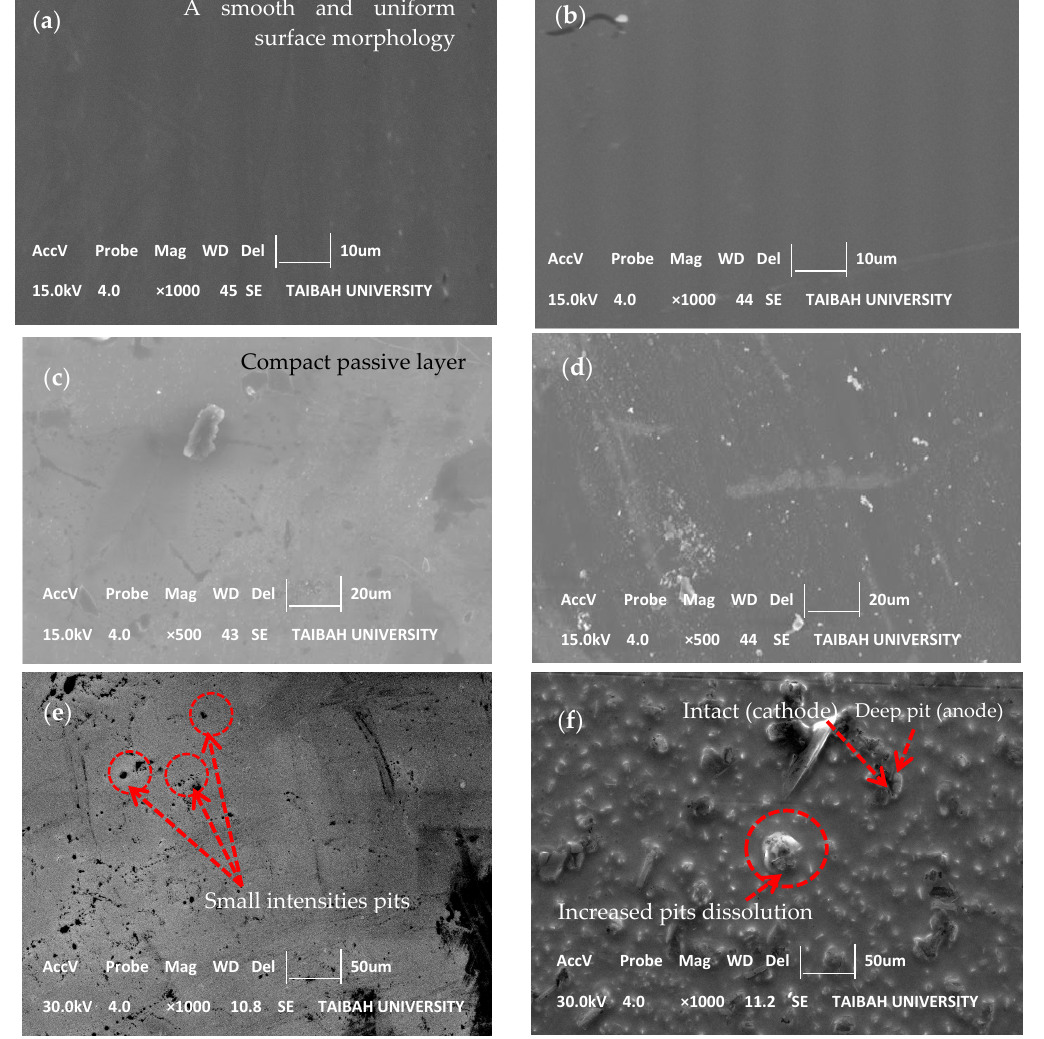
Figure 6. SEM morphology for Ni-base glassy alloys at as-received and different concentration of NaOH solutions at 27 °C: ( a ) as-received VZ1 alloy; ( b ) as-received VZ2 alloy; ( c , d ) VZ1 alloy at 1.0 M and 12.0 M NaOH; ( e , f ) VZ2 alloy at 1.0 M and 12.0 M NaOH.